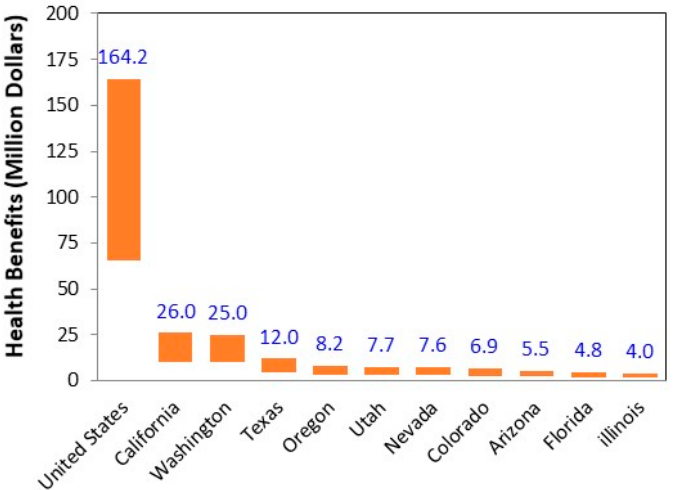
Figure 2. Range of estimated annual health benefits for the top ten state beneficiaries from the Nevada 50% RPS policy across the high- and low-demand scenarios by 2030. The maximum health benefits are indicated in blue.